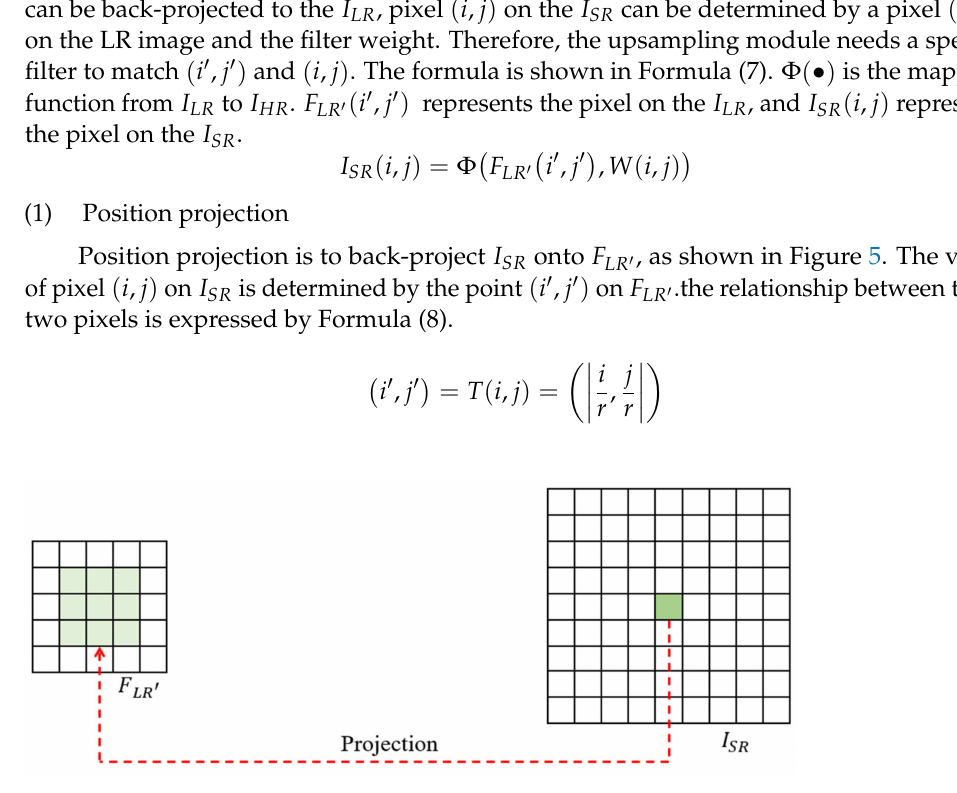
Figure 5. Location projection schematic